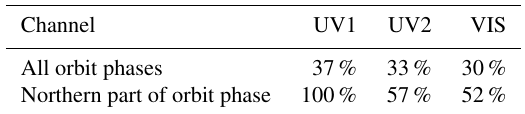
Table 4. Percentage of the RA-affected rows, as of August 2014.